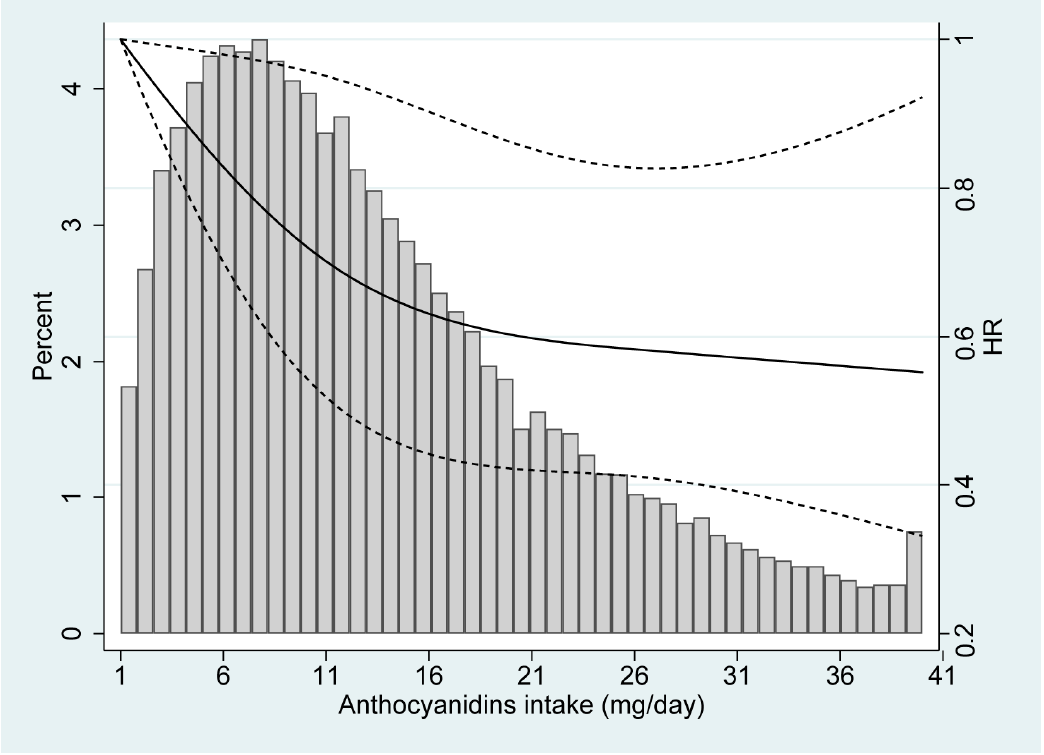
Figure 1. Dose-response relationship between dietary anthocyanidin intake and renal cancer risk, based on a restricted cubic spline, which adjusted for age, sex, race, body mass index, education level, smoking status, hypertension status, and total energy intake ( p for nonlinearity =